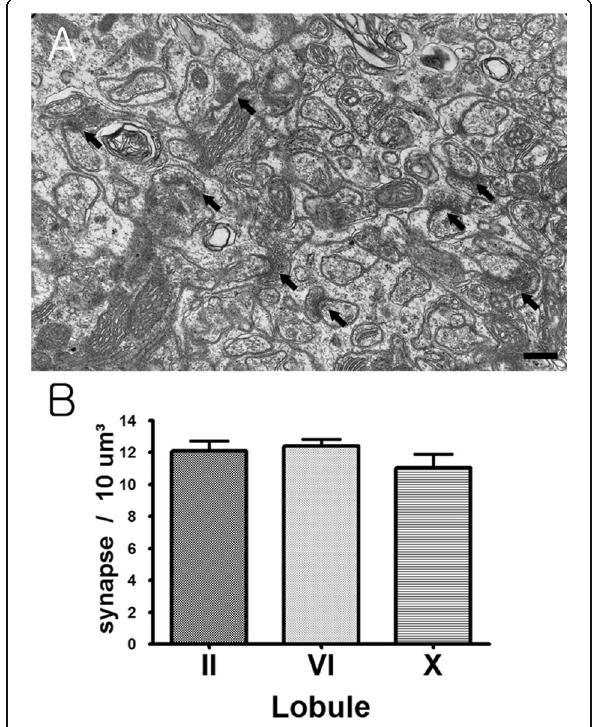
Fig. 3 Transmission electron microscopy image of synapse and estimation of synapse density. This shows Purkinje cell dendritic spine synapse of molecular layer in cerebellum. Used transmission electron microscopy. a Indicate is synapse of molecular layer in cerebellum (arrows). × 60,000 Bar = 1 μ m. b Histogram of